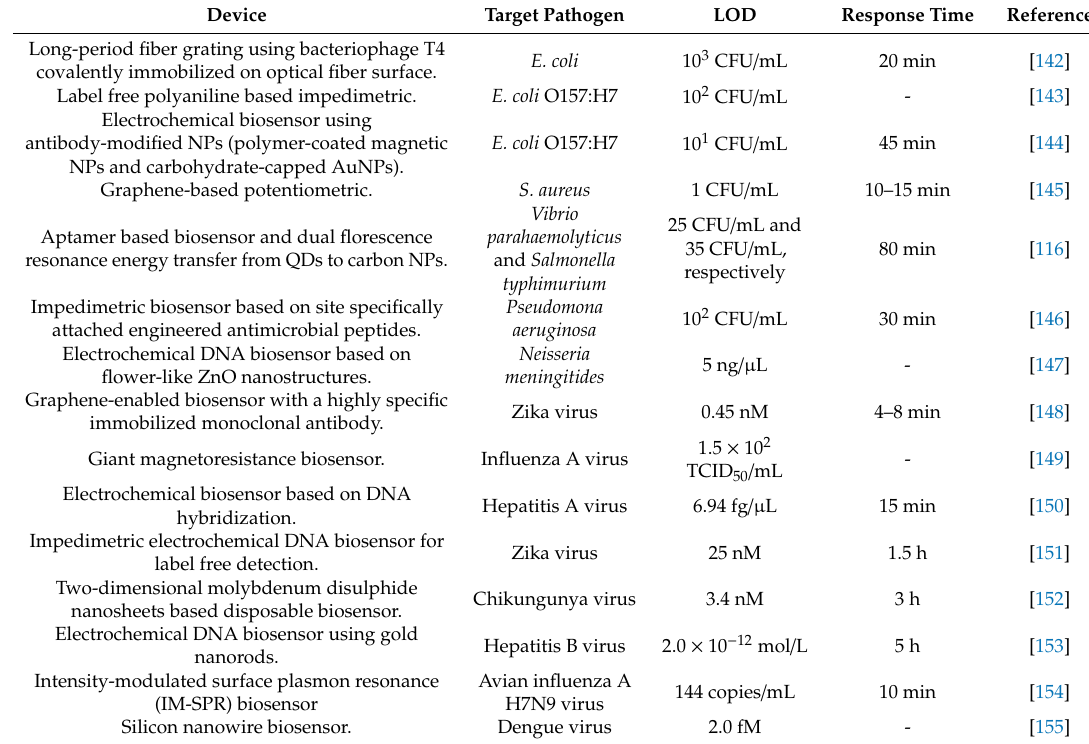
Table 1. Developed biosensors for detecting bacterial and viral pathogens in the human body.